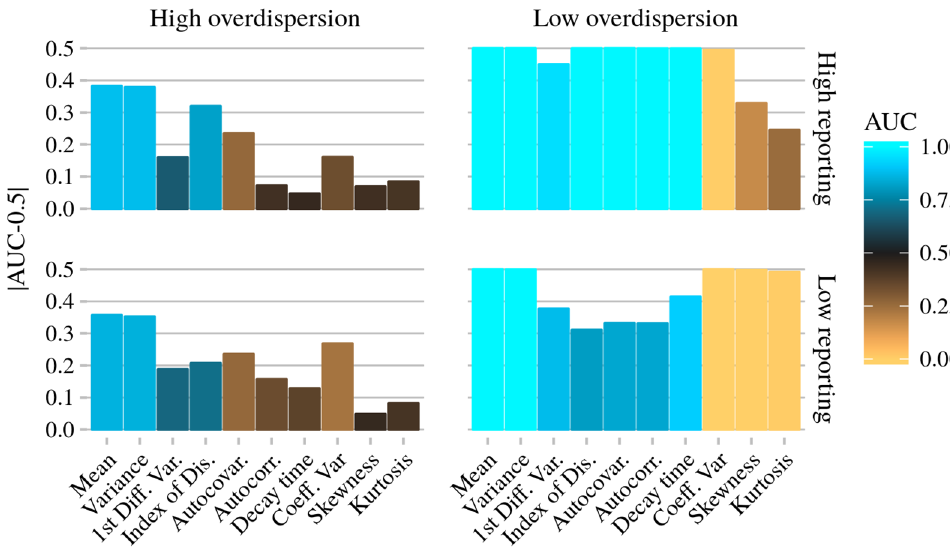
Fig 6. Performance of EWS under high/low reporting probability and high/low overdispersion scenarios. For high reporting ρ = 1.0 and low reporting ρ = 0.047. For high overdispersion ϕ = 0.01, for low overdispersion ϕ = 100. For all panels both the mean infectious period and aggregation period are 7 days. AUC values are from the same data set used in Fig 5. timescale T . Examples of the simulated time series are shown in S5 Fig, using the same report- ing process parameters as in Fig 6.